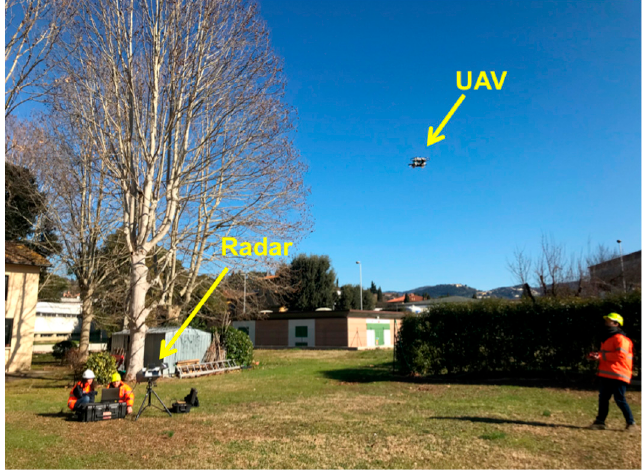
Figure 15. Detection of a small unmanned aerial vehicle (UAV) using an SFCW radar.